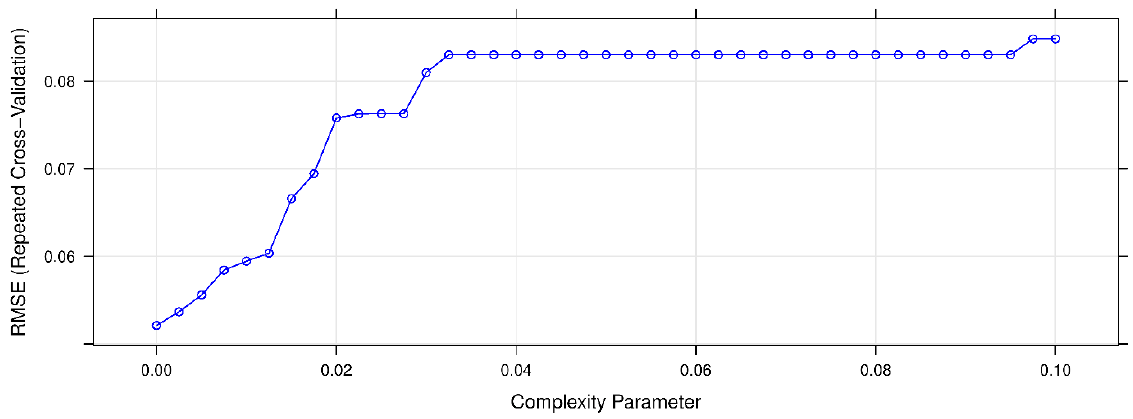
Figure 9. Root-mean-squared error (RMSE) of the classification and regression trees (CART) model with various cp values on the training dataset.